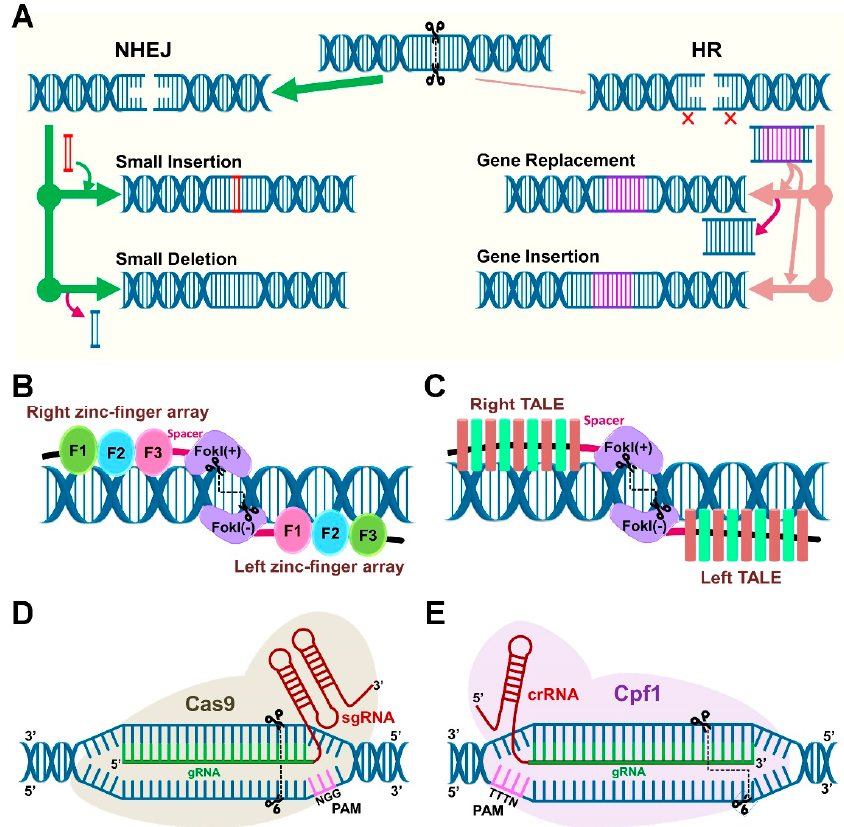
Figure 3. Biology and components of site-specific nucleases (SSNs) modified for genome editing applications. ( A) Repair of double-strand breaks (DSBs) in damaged DNA strands occurs through two main pathways that consist of non-homologous end-joining (NHEJ) and homology-directed repair (HDR). NHEJ is most common in cells. It is an error-prone pathway that introduces indel mutations (small insertions or deletions). HDR is more precise compared to NHEJ, but it requires a donor template that results in either insertion or replacement. ( B ) Zinc finger nuclease (ZNF) is designed using an array of DNA-binding domains from zinc-finger proteins. Each ZFN comprises DNA-binding domain at N-terminus and FokI nuclease at C-terminus. The linker and spacers are shown in black and pink, respectively. ( C ) Design of transcription activator-like effectors (TALE) protein-based nuclease (TALEN) bound to DNA. ( D ) Illustration of clustered regularly interspaced short palindromic repeats (CRISPR)/Cas9 with a sgRNA (red) encoding gRNA (green) bound to a target DNA (blue) adjacent to PAM, i.e., protospacer adjacent motif (magenta). Cleavage sites on both strands shown with scissors and dotted line depict the blunt ends produced by Cas9. ( E ) CRISPR/Cpf1 (Cas12a) system shown with a crRNA (red), a gRNA (green), target DNA (blue), PAM (magenta). Cleavage sites of both strands (scissors) produce staggered ends (dotted line) with Cpf1.